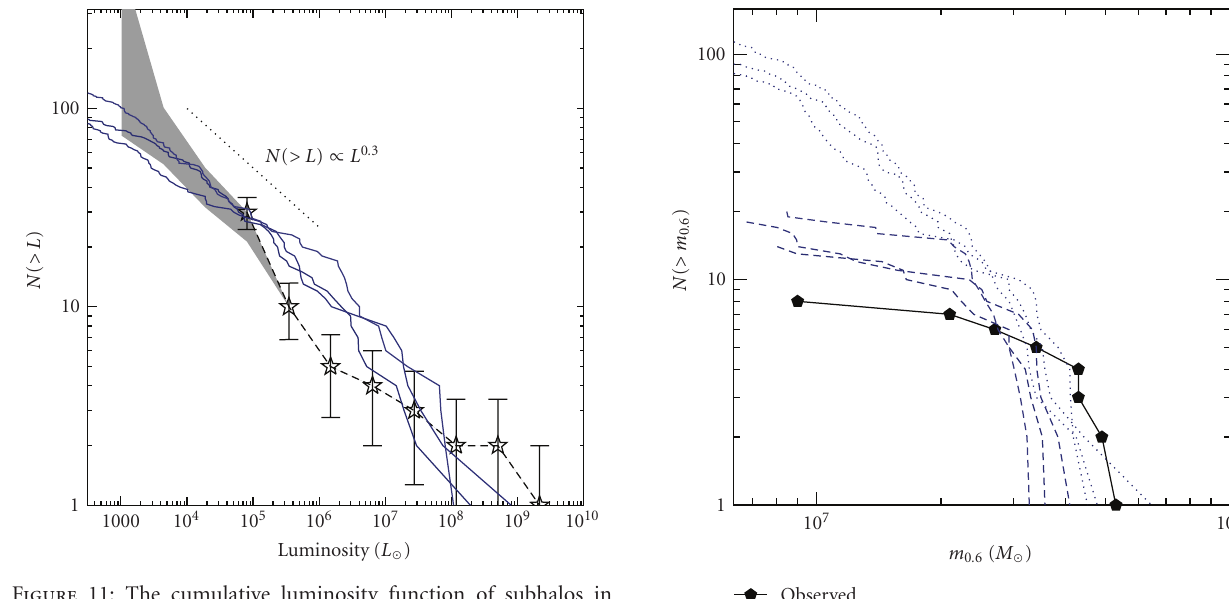
Figure 11: The cumulative luminosity function of subhalos in the three MW-sized halos shown in Figure 10 with the simple luminosity assignment ansatz of (4). The luminosity function includes all subhalos within 417 kpc from the center of each halo, the same radius as was used to construct the luminosity function of the observed satellites shown in Figure 6. The points with (Poisson) error bars, connected by the dashed line, and the shaded region show the observed and inferred satellite luminosity functions within the same radius for classical and ultra-faint dwarfs, respectively, as compiled by [56] (see text for details).